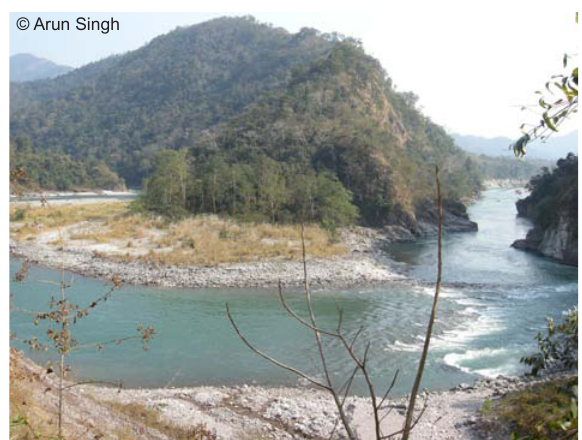
Image 4. Sankosh River flowing through Kalikhola-Huma Khola transect near dam site during winter (January)